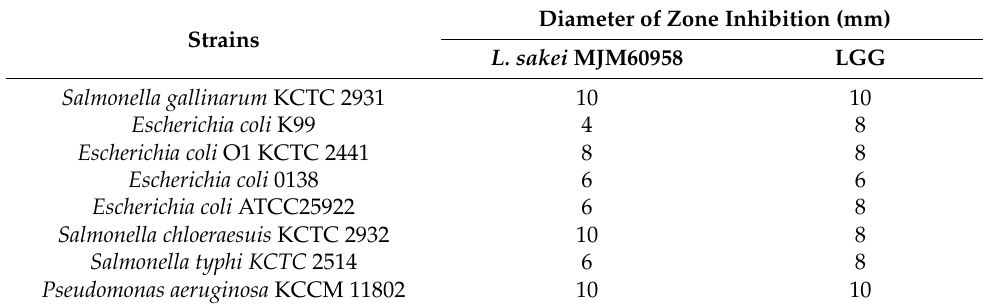
Table 3. Oro-gastrointestinal transit assay of L. sakei MJM60958 and L. rhamnosus GG. OGI Transit Initial